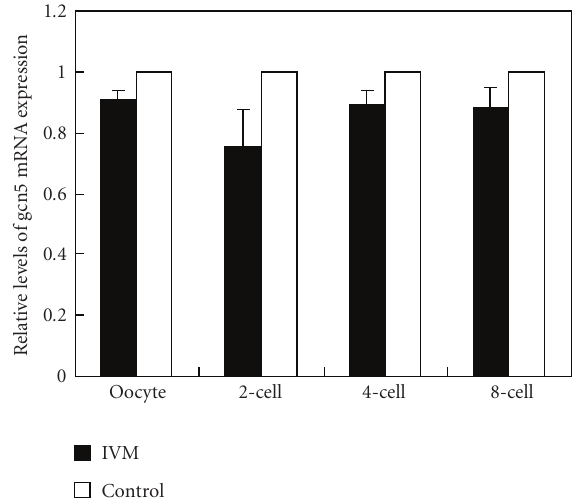
Figure 2: mRNA expressions of GCN5 in oocytes and embryos. The comparison of GCN5 mRNA expression was made between IVM and control groups. Summary data showed the relative expression levels of GCN5 in oocytes and embryos after real-time PCR analysis. The relative mRNA levels represent the amount of mRNA expression normalized with